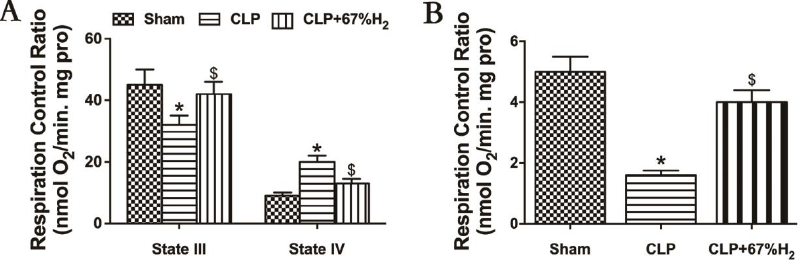
Figure 5. Hydrogen treatment could maintain mitochondrial structural integrity. State III: oxygen consumption rate under ADP presence. State IV respiration rate: the oxygen consumption rate with ADP exhausted. RCR is the value of state III/state IV. ( A ) State III and IV respiration rate; ( B ) RCR. Values are expressed as mean ± SD ( n = 6). * p < 0.05 versus the Sham group. $ p < 0.05 versus CLP group.